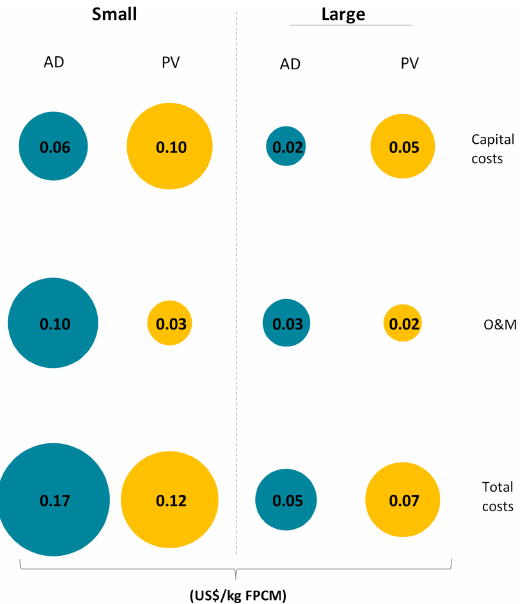
Figure 5. Capital, operation, and maintenance (O&M), and total annualized costs per unit of milk produced (kg FPCM) of installing an AD or solar PV systems in the small and large base-case farms. Costs consider sizing the AD and PV systems to achieve GHG neutrality in farms without any renewable energy